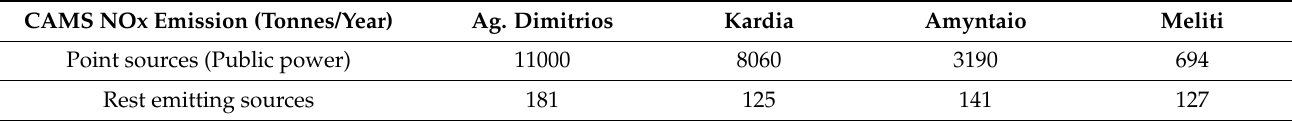
Table 1. Annual NO x emissions from CAMS-REG emission inventory based on 2015 for the point sources of category A (public power) and the sum of sectors from area sources at the four grid pixels where the power plants are located. CAMS NOx Emission (Tonnes/Year) Ag. Dimitrios Kardia Amyntaio Meliti Point sources (Public power) 11000 8060 3190 694 Rest emitting sources 181 125 141